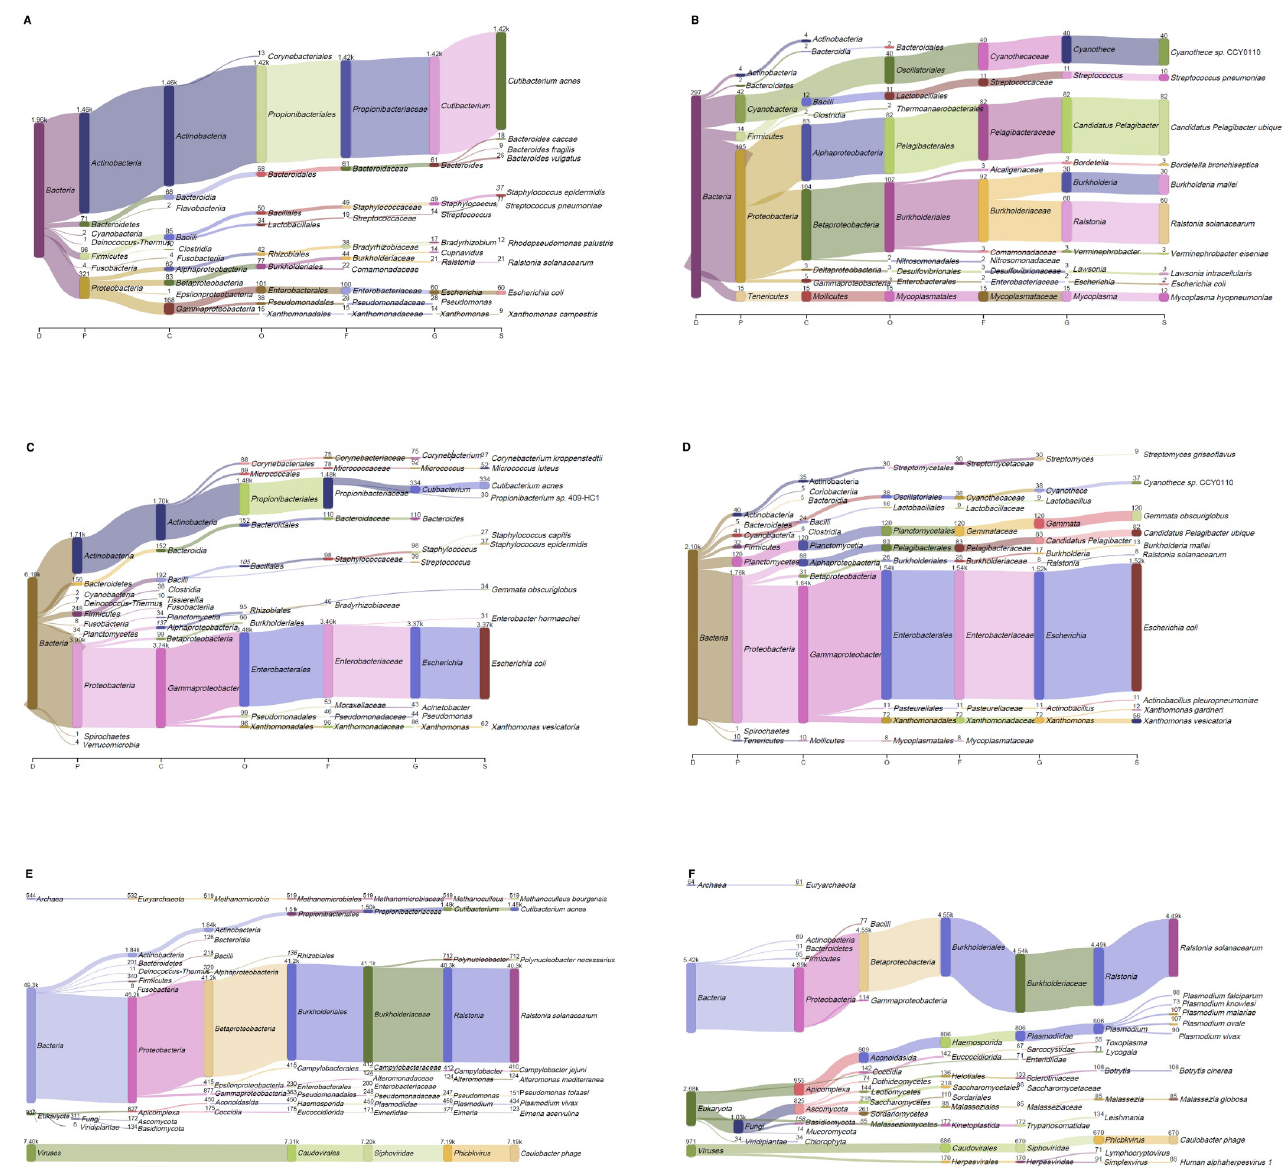
Fig 4. Example of microbial composition in negative control (A, C, E) or chorionic villi (B, D, F) using different databases for analysis with KrakenUniq. DNA was found in both negative control and chorionic villi and was highly variable depending on the database. Databases used: RefSeq v24 (A, B); RefSeq v48 (C, D); NCBi ‘nt’ (E,